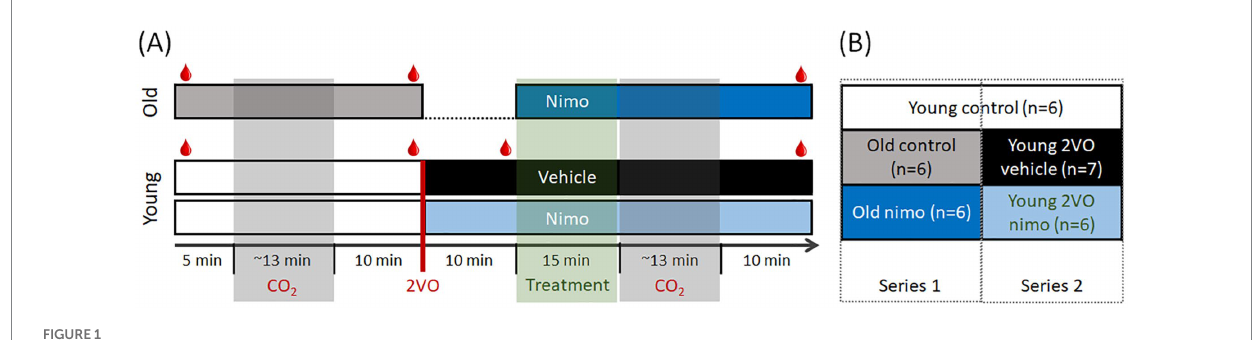
FIGURE 1 Experimental protocols (A) and experimental conditions compared (B) . For blood gas analysis, arterial blood samples were collected repeatedly ( in A). Number of cases per group are given (B) after implementing the exclusion criteria. 2VO, bilateral common carotid artery occlusion; Nimo,